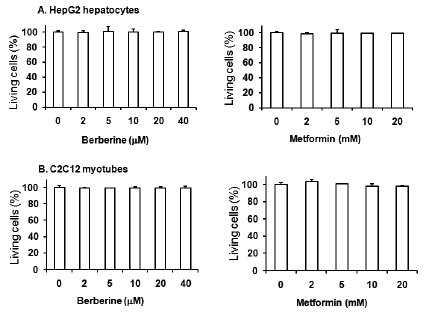
Figure 2. Berberine showed no cytotoxicity. Cells were starved in serum-free DMEM supplemented with 0.25% BSA and treated with various doses of berberine or metformin for 24 h. LDH concentrations in medium and cells were detected. A: berberine or metformin treatment had no cytotoxicity in HepG2 hepatocytes. B: berberine or metformin treatment had no cytotoxicity in C2C12 myotubes. Data are expressed as means 6 SEM; n= 8.